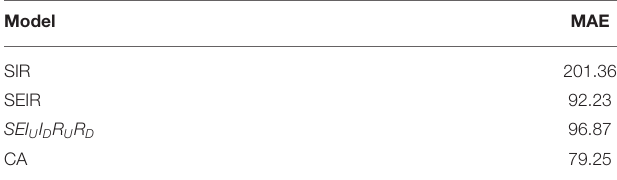
TABLE 6 | MAE for models in Potter